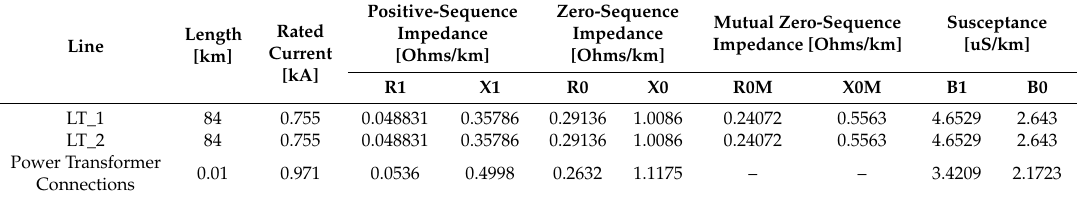
Table A4. Electrical parameters for the transmission lines used in the sample power